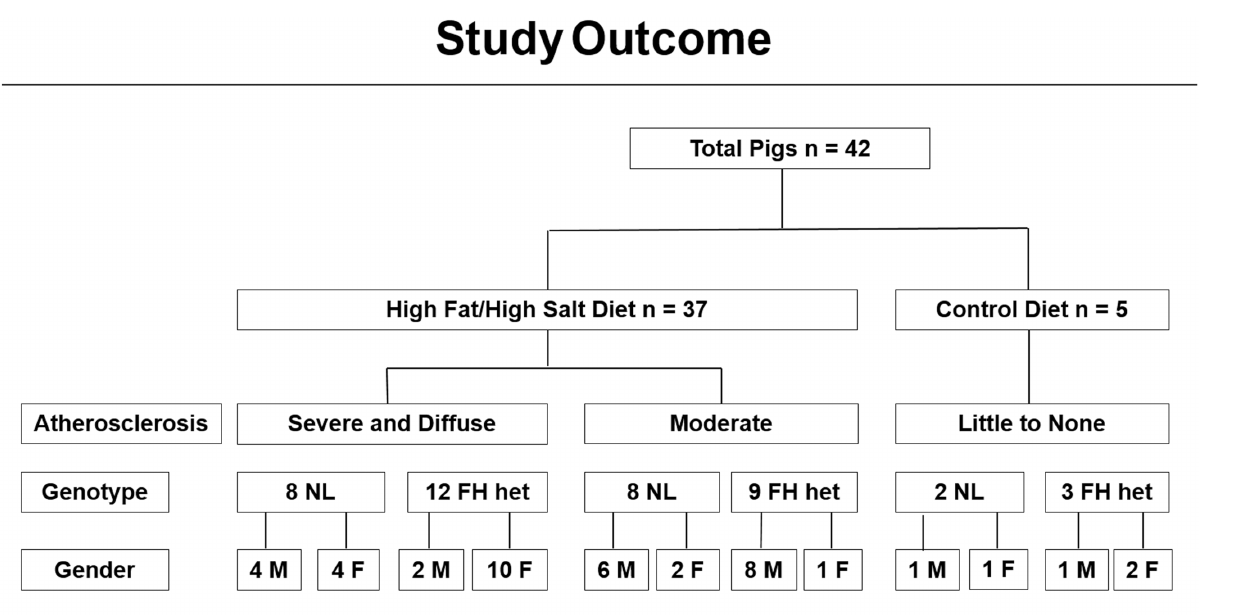
Fig 2. Study Outcome. The 42 pigs are described as in Fig 1 and grouped by atherosclerosis phenotype that developed during the 12-month study.